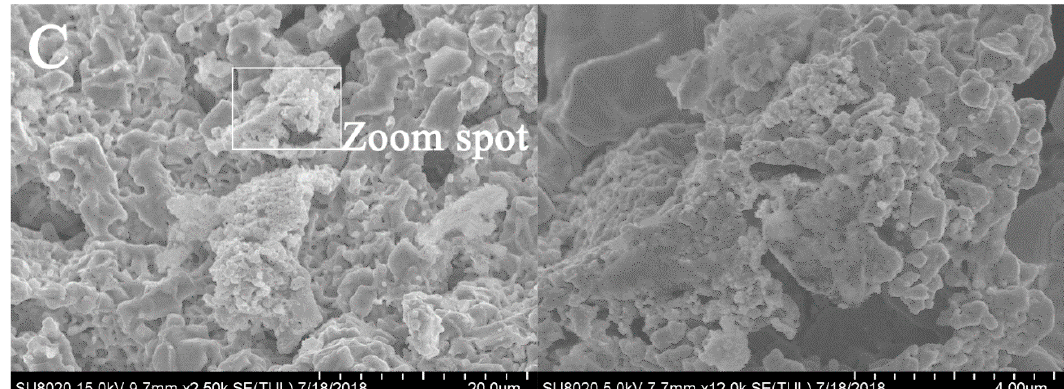
Figure 6. SEM image of the ( A ) used MPy at the bottom of the column, ( B ) used MPy at the middle of the column, ( C ) used MPy at the top of the column. The regions analyzed by EDS and magnified regions are labeled.